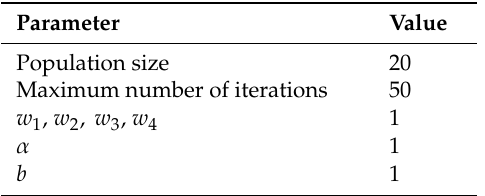
Table 2. Setting parameters of the proposed method.